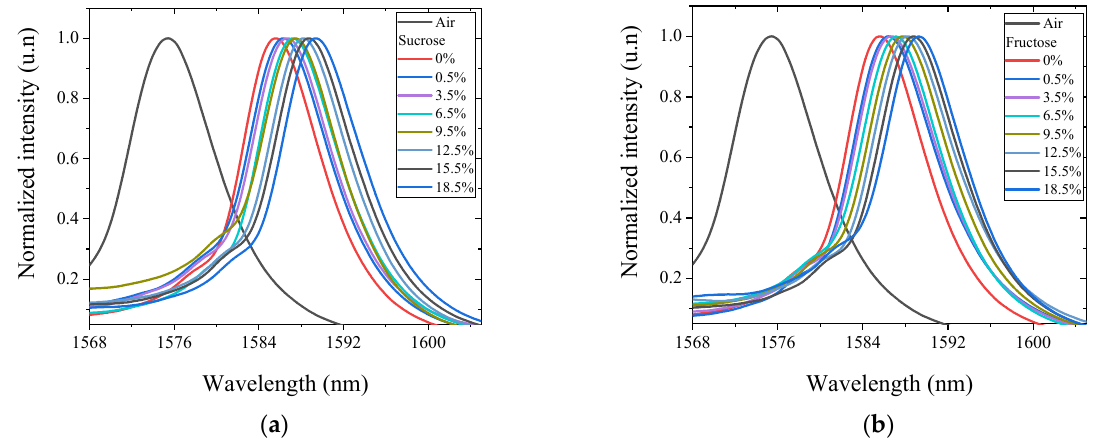
Figure 2. Spectral response of the MMI sensor for different concentrations of sugar dissolved in distilled water: ( a ) Sucrose spectral displacement; ( b ) Fructose spectral displacement.